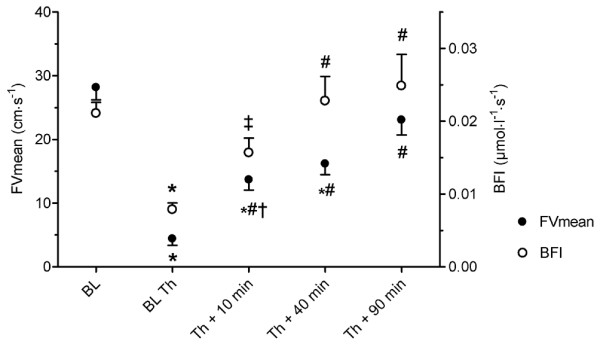
Blood flow velocity by transcranial Doppler ultrasound and bood flow index (BFI) by near infrared spectroscopy at the different experimental stages (BL, baseline; BL Th, start therapy; Th + 10 min, after 10 minutes of therapy; Th + 40 min, after 40 minutes of therapy; Th + 90 min, after 90 minutes of therapy). Data are given as mean ± standard error of the mean; *p < 0.001 versus baseline; #p < 0.001 versus baseline therapy; ‡p < 0.01 versus baseline therapy; †p < 0.05 versus therapy + 90 minutes. FVmean, mean blood flow velocity in the right middle cerebral artery.